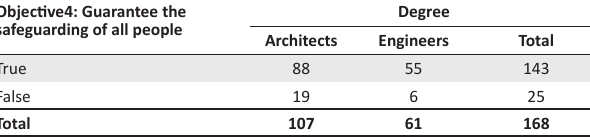
TABLE 12: Effect 2 (suffers